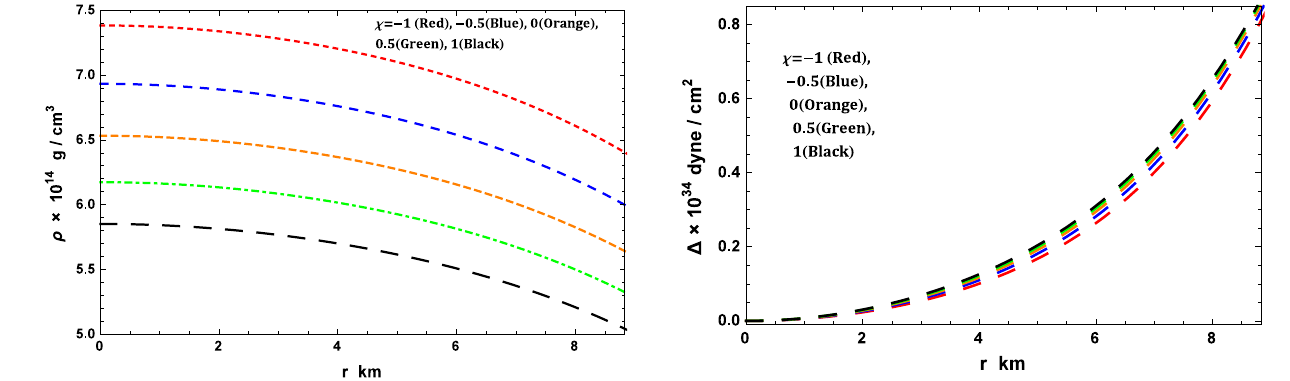
Fig. 2 Density profile of SMC X-4 w.r.t radial coordinate r for M =